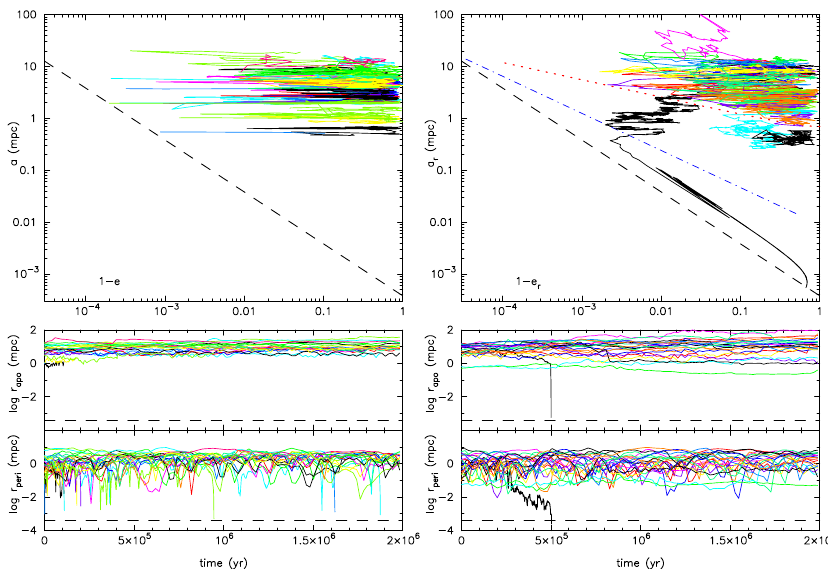
Fig. 54 The Schwarzschild barrier. In the left panel, we have the Newtonian case and in the right one the simulations with relativistic corrections. We clearly see the barrier and also a particle crossing it. Images reproduced with permission from arXiv e-print of Merritt et al.